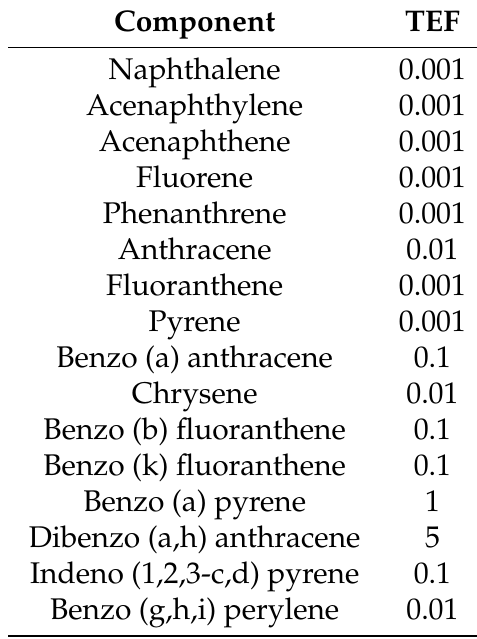
Table 2. Toxic Equivalency Factor values of 16 priority polycyclic aromatic